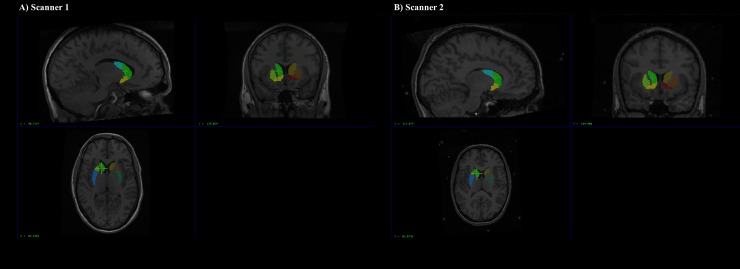
Regions of interest.Region of interest labels in native space produced by MAGeT-Brain in a randomly selected subject from Scanner 1 (A) and Scanner 2 (B).